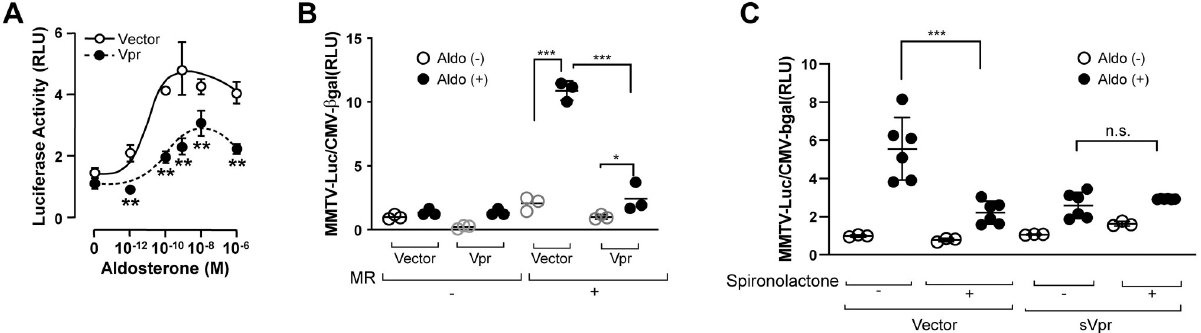
Fig 4. Suppression of MR transcriptional activity by Vpr in African green monkey kidney (CV-1) cells. ( A ) CV-1 cells, lacking MR, were transfected with Vpr- and MR-expressing plasmids. MR-mediated transcription activity, monitored by the MR-responsive MMTV-luciferase reporter, exhibited a sigmoidal dose-response to aldosterone and across the aldosterone concentration range, which was inhibited by Vpr. ( B ) Vpr markedly suppressed MR transcriptional activity in CV-1 cells transfected with MR and cultured with aldosterone (100 nM). ( C ) Both sVpr and MR antagonist spironolactone (1 μ M) suppressed aldosterone-induced (100 nM) MR transcription activity; the spironolactone-mediated suppression was not further reduced by sVpr. n = 3–6. n.s., not significant; � P < 0.05, ��� P < 0.001, ANOVA, Bonferroni correction.